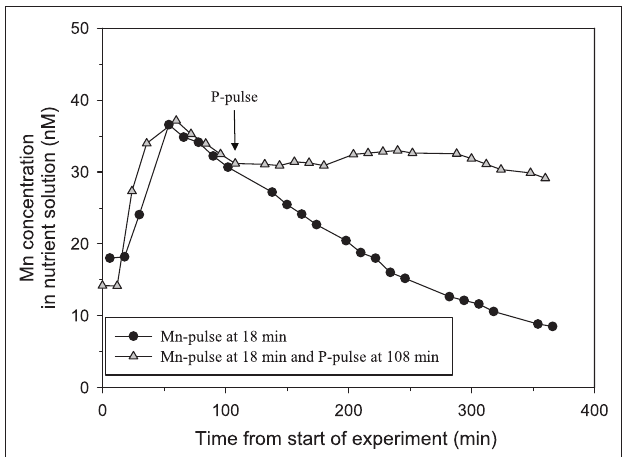
FIgure 4 | The direct effect of addition of a pulse of 200 μM K on Mn net uptake in 25-day-old plants of the Mn-efficient genotype Vanessa as measured by on-line ICP-MS. Two Mn pulses were given, the second followed by an additional pulse of 200 μM KCl (triangles). The experiment was repeated several times with similar results. The shoot and root weight were 4.51 and 2.90 g